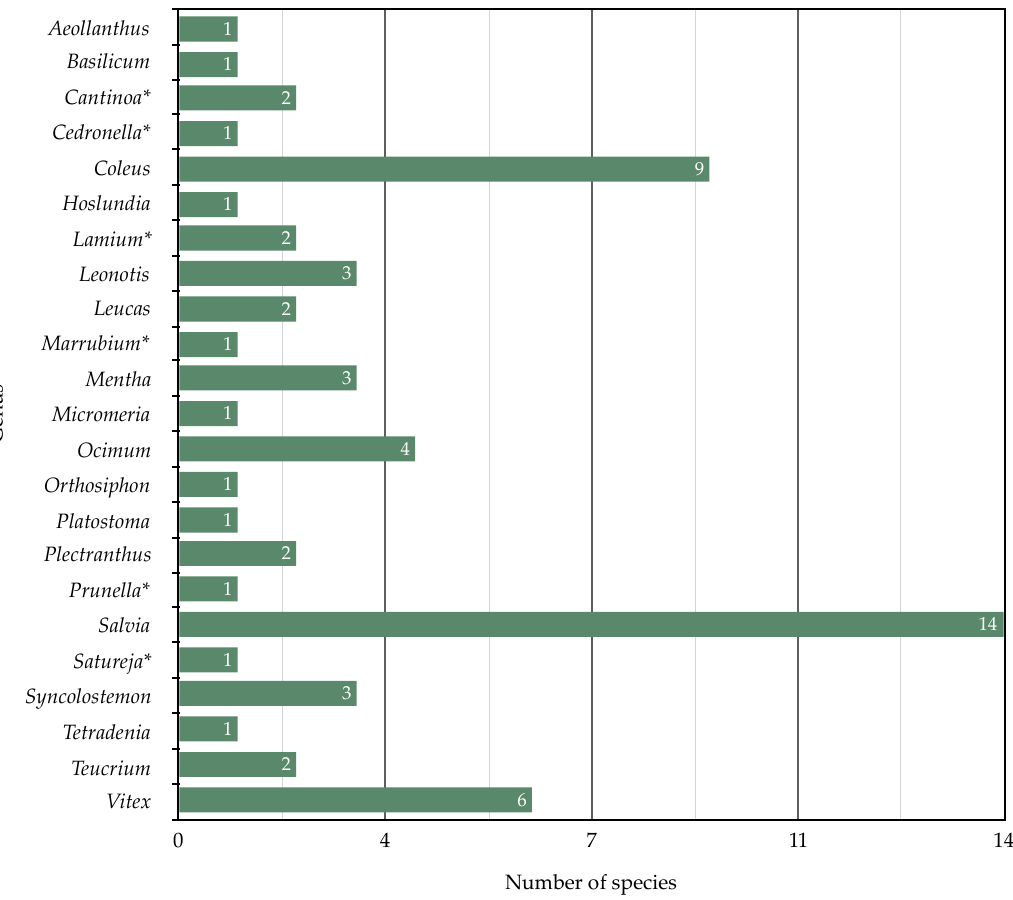
Figure 4. The numbers of species from 23 genera (out of 42) of southern African Lamiaceae that have been studied for their essential oil composition.